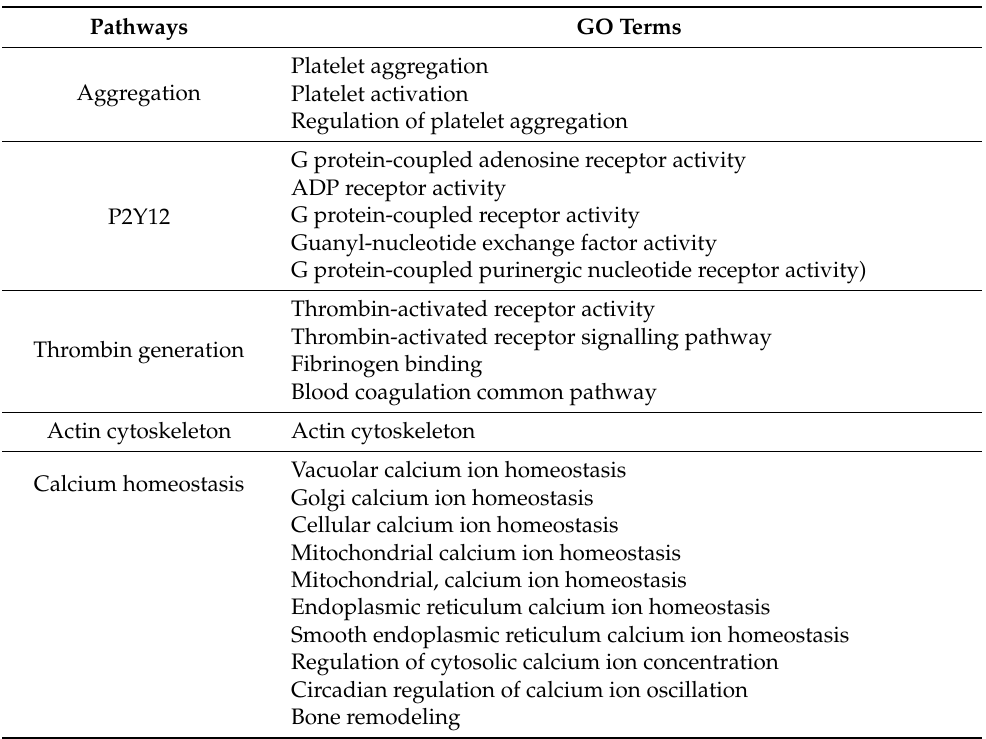
Table 1. Gene ontology (GO) terms related to platelet aggregation and thrombin generation pathways. Pathways GO Terms Platelet Aggregation